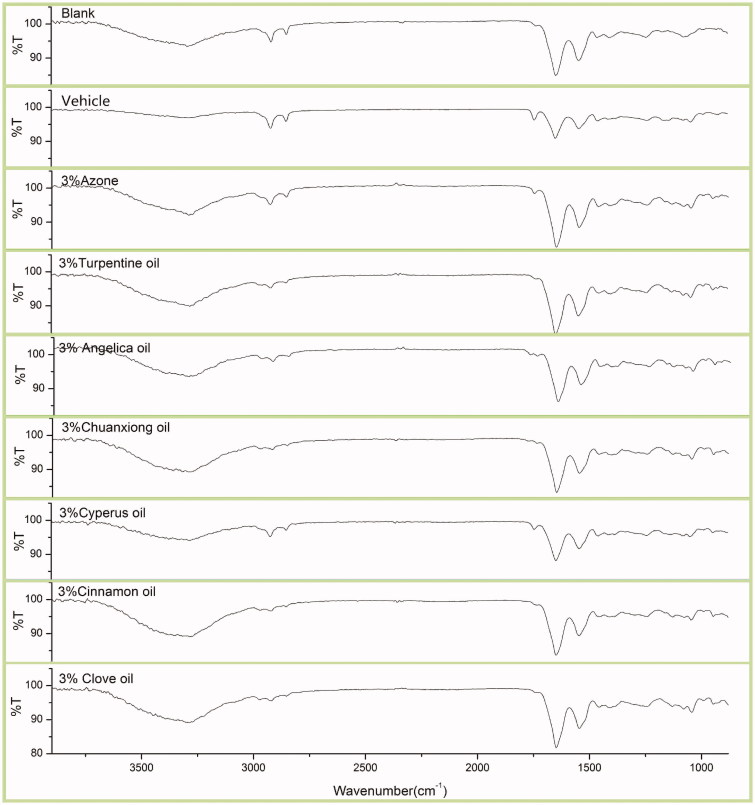
ATR-FTIR absorption spectra of rat skin treated with 3% w/v EOs.